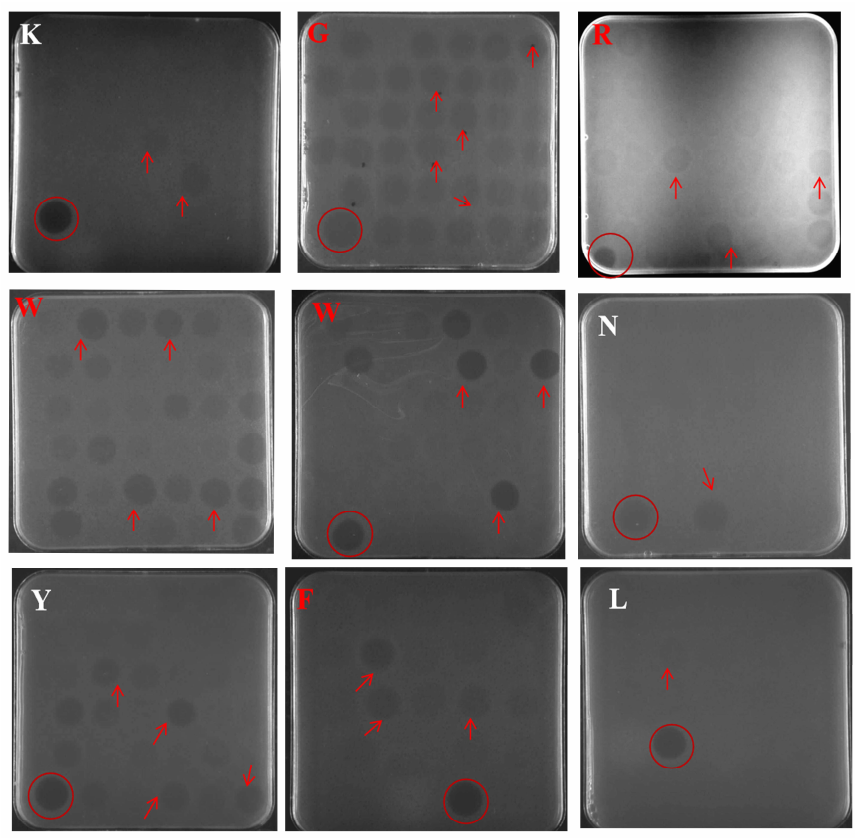
Figure 2. The inhibition zones of XNZ fermentation supernatants in 48-well plates. The circle is marked as the NZ2114 control; the arrow represents the screened positive transformants.